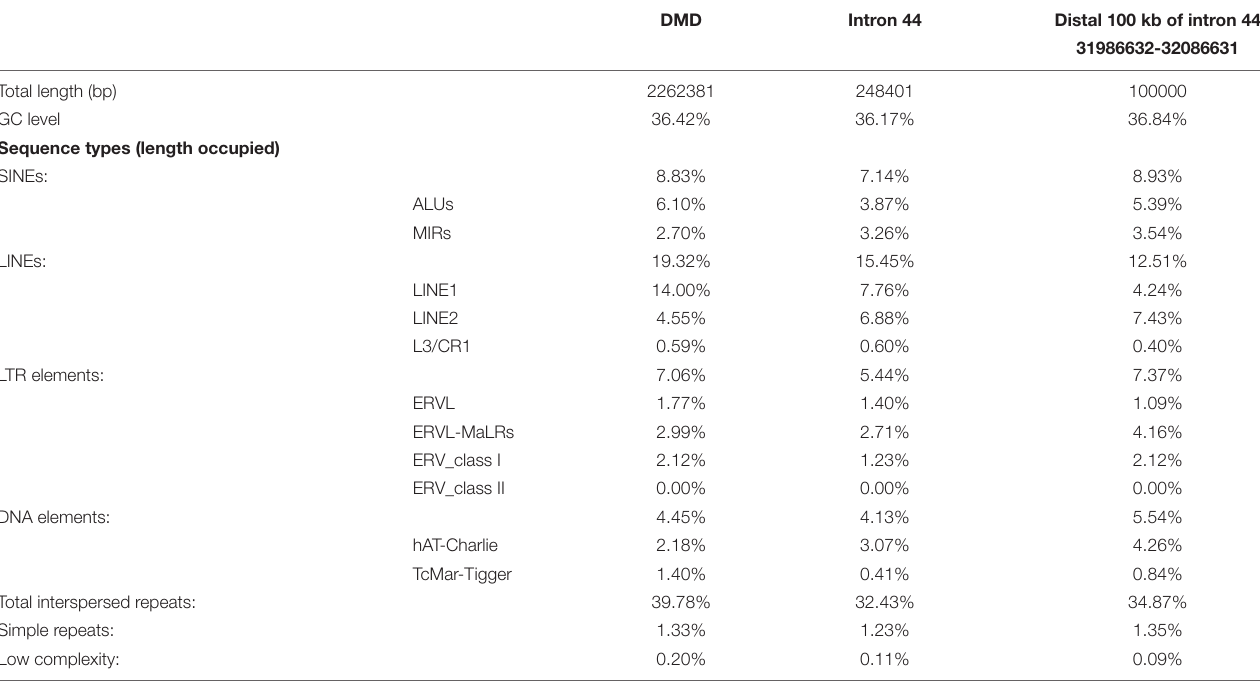
TABLE 1 | Repetitive sequences in the DMD gene and intron 44 of the DMD gene.